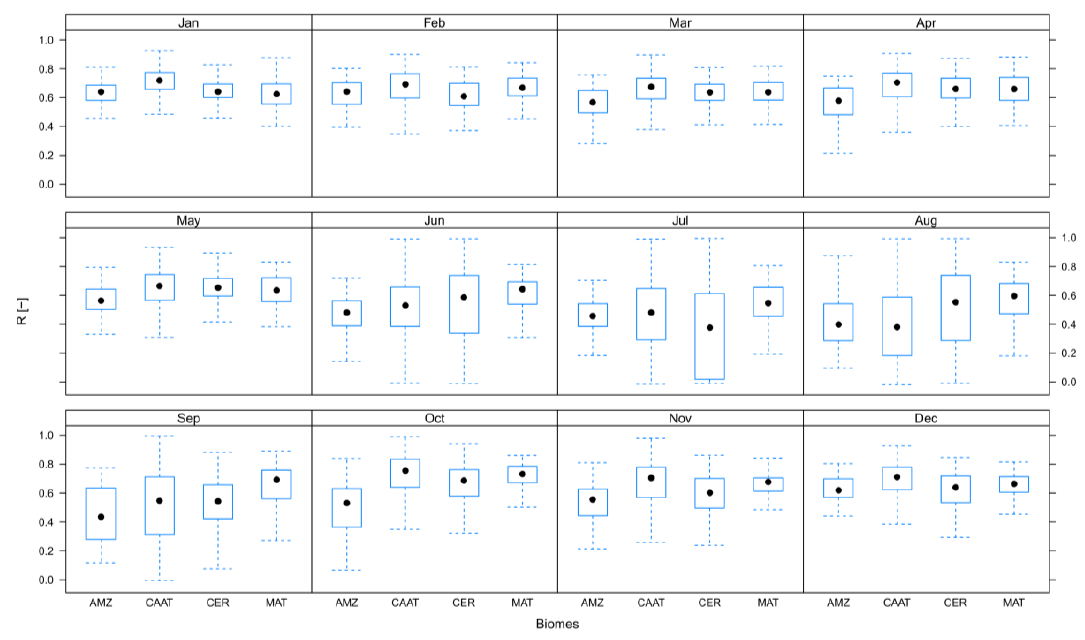
Figure 11. As per Figure 7, but for the MSWEP rainfall product.